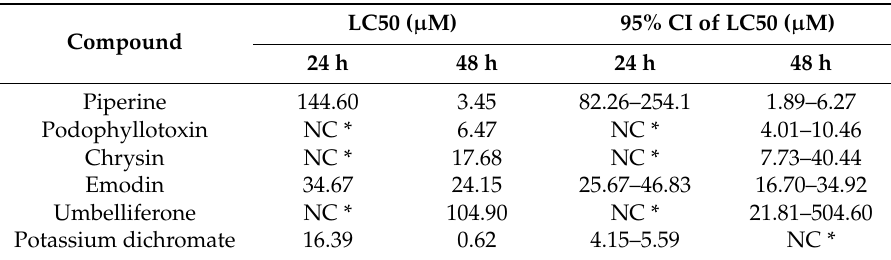
Table 4. Results of the Daphnia magna bioassay.